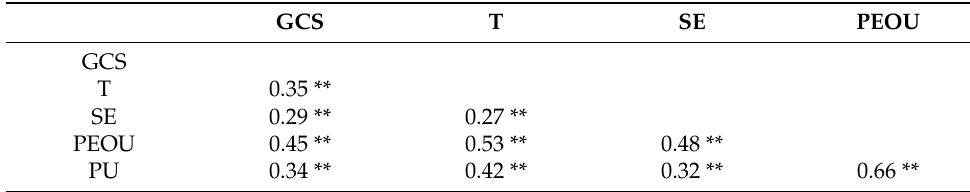
Table 6. Correlation coefficients between measured